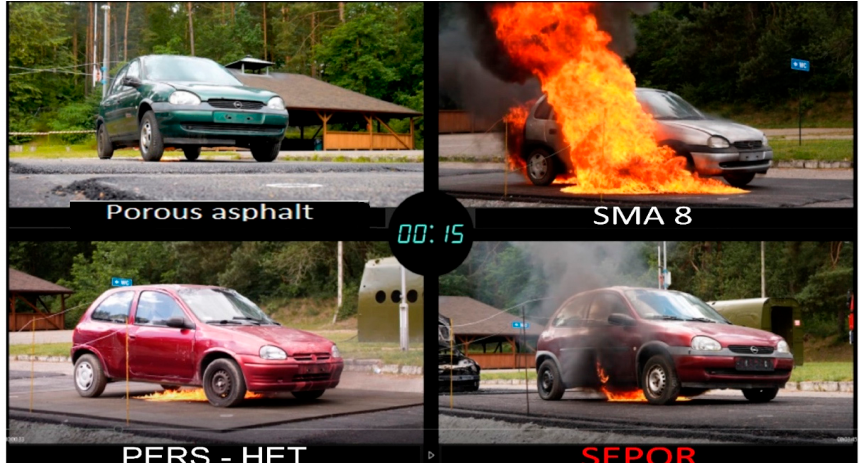
Figure 34. Fire development 15 s after ignition.